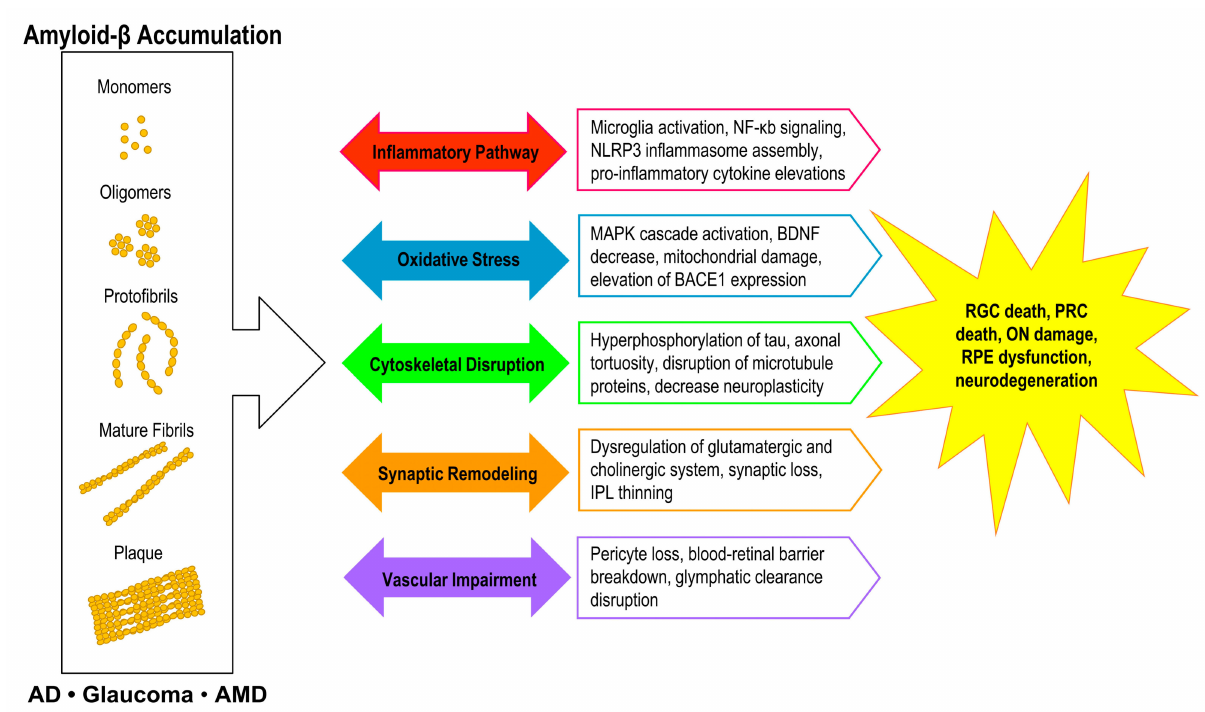
Figure 3. Flowchart for overlapping retinal amyloid- β (A β )-associated mechanisms and effects in AD, glaucoma, and AMD. Elevated A β levels in various structural formations, especially oligomers and plaques, have been associated with increased upregulation of pathology cascades. These pathways have been associated with increased A β accumulations and increased neurodegeneration with a potential loss of cognition and vision. Abbreviations: AD: Alzheimer’s disease; AMD: age-related macular degeneration; NF- κ b: nuclear factor kappa B; NLRP3: NLR family pyrin domain containing 3; MAPK: mitogen-activated protein kinase; IPL: inner plexiform layer; RGC: retinal ganglion cell; PRC: photoreceptor cell; ON: optic nerve: RPE: retinal pigment